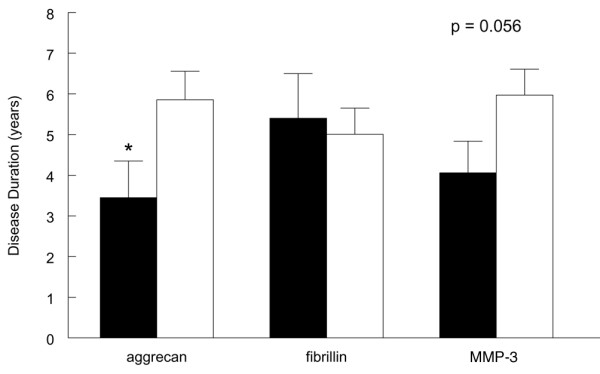
Relation of disease duration and T-cell proliferative responses induced by aggrecan, fibrillin, and matrix metalloproteinase (MMP)-3. Proliferative activity of peripheral blood mononuclear cells from patients with juvenile idiopathic arthritis was dichotomized as follows: stimulation index (SI)-non-responsive < 2 ≤ SI-responsive. Responders to the aggrecan peptide had the lowest disease duration (p = 0.016). Responders to the MMP-3 peptide showed a similar trend, which was close to reaching statistical significance (p = 0.056). Black bars: responders; transparent bars: non-responders. Asterisk indicates significant difference.